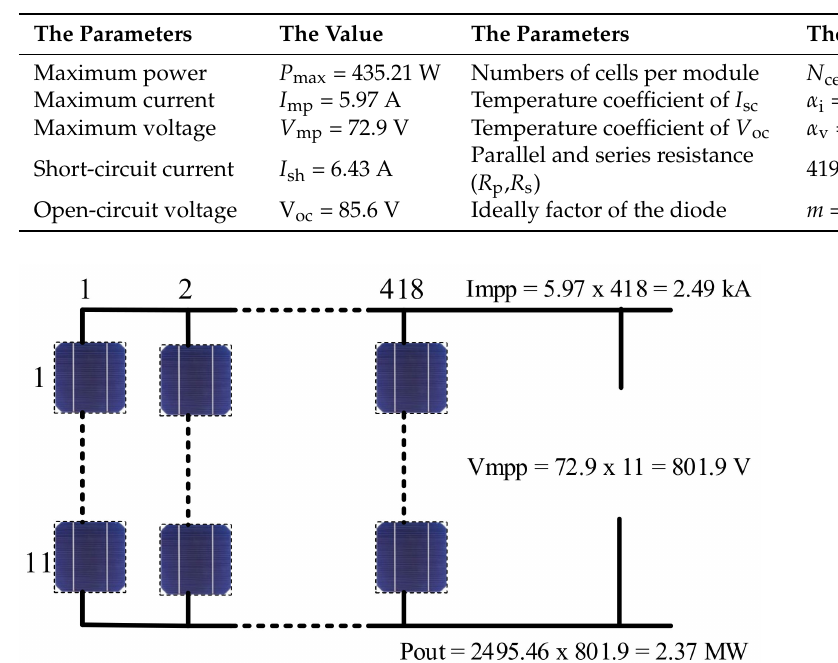
Table 1. SunPower SPR-435 NE-WHT-D module specifications.